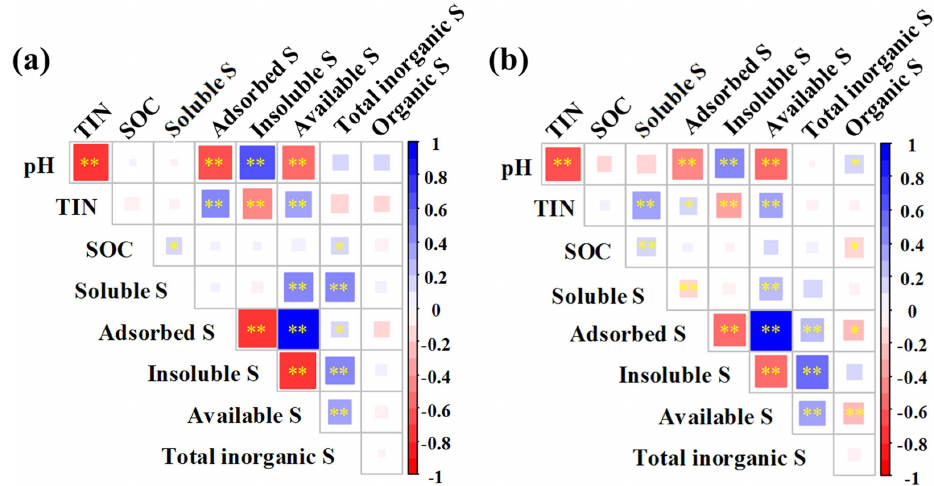
Figure 6. Correlations between soil parameters and S fractions with low (a) and high (b) frequencies of N addition across differing N addition intensities and mowing treatments. The color change from blue to red indicates correlations from positive to negative as exhibited in bars at right side of each panel. The symbols * and ∗∗ represent significance levels of 0.05 and 0.01,